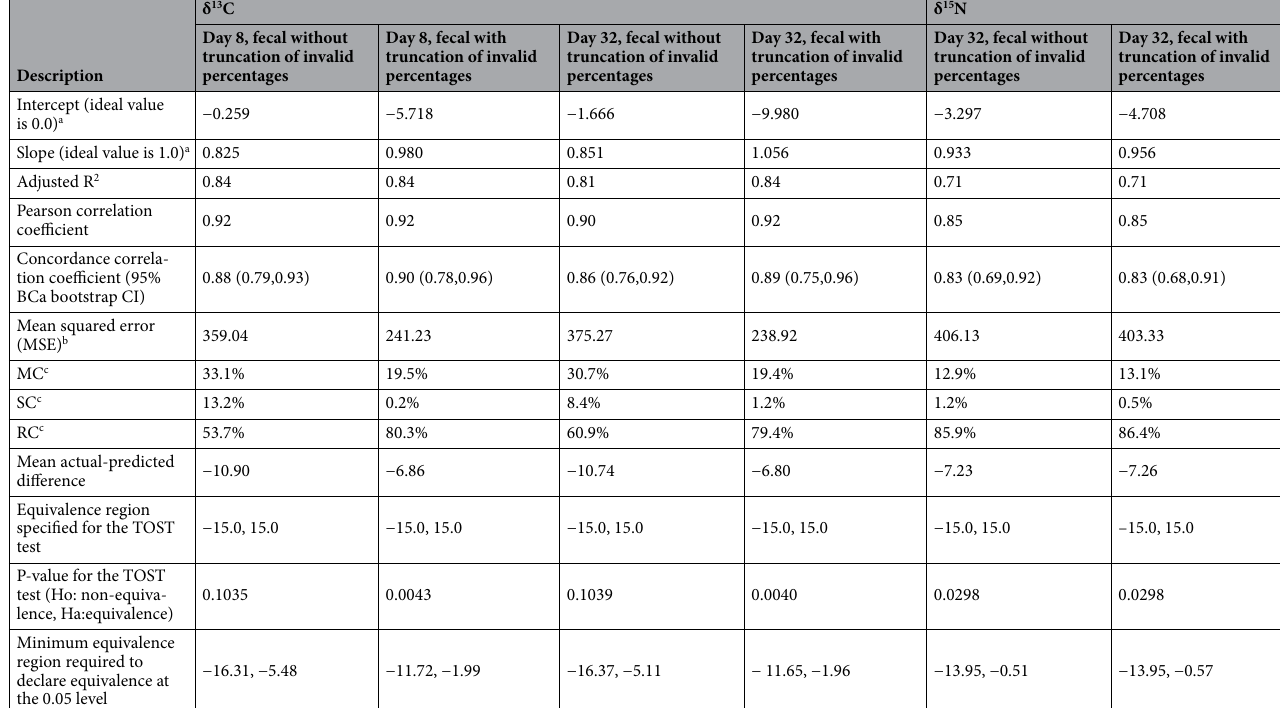
Table 4. Analytic regression analysis results of predicted vs. actual proportions of rhizoma peanut into bahiagrass hay diets consumed by beef cattle. Fecal samples were analyzed for δ 13 C and δ 15 N and diets were reconstructed using two-pool mixing models. Truncated values indicate predicted values re-assigned appropriate boundary value, where predicted proportions of < 0% were assigned a value of 0% and those > 100% were assigned a value of 100%. a From a model regressing actual on predicted dietary proportions . b Mean squared error where ’error’ is the predicted minus actual dietary proportion . c MC, SC, RC are mean, slope, random components of the MSE (as percentages),